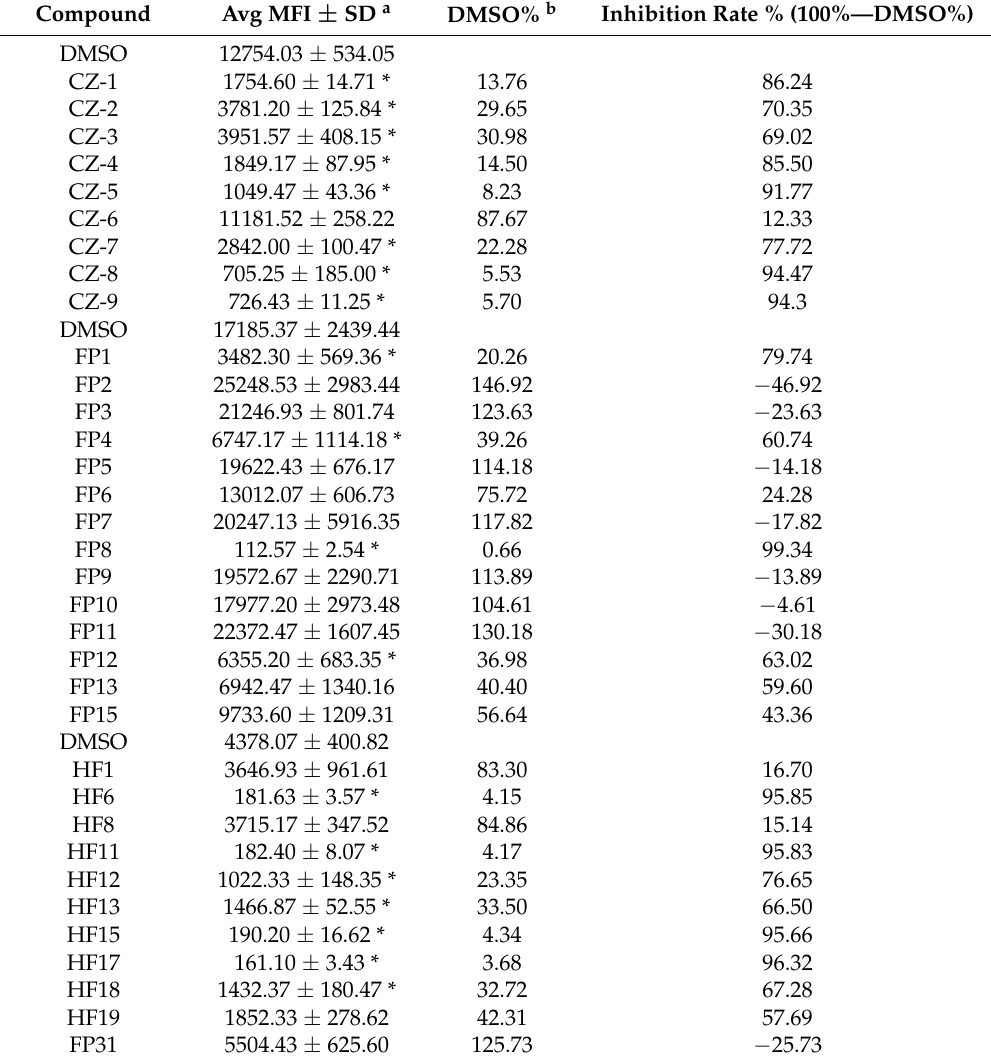
Table 1. Screening for inhibitors of Xoo T3SS by fluorescence-activated cell sorting assays.